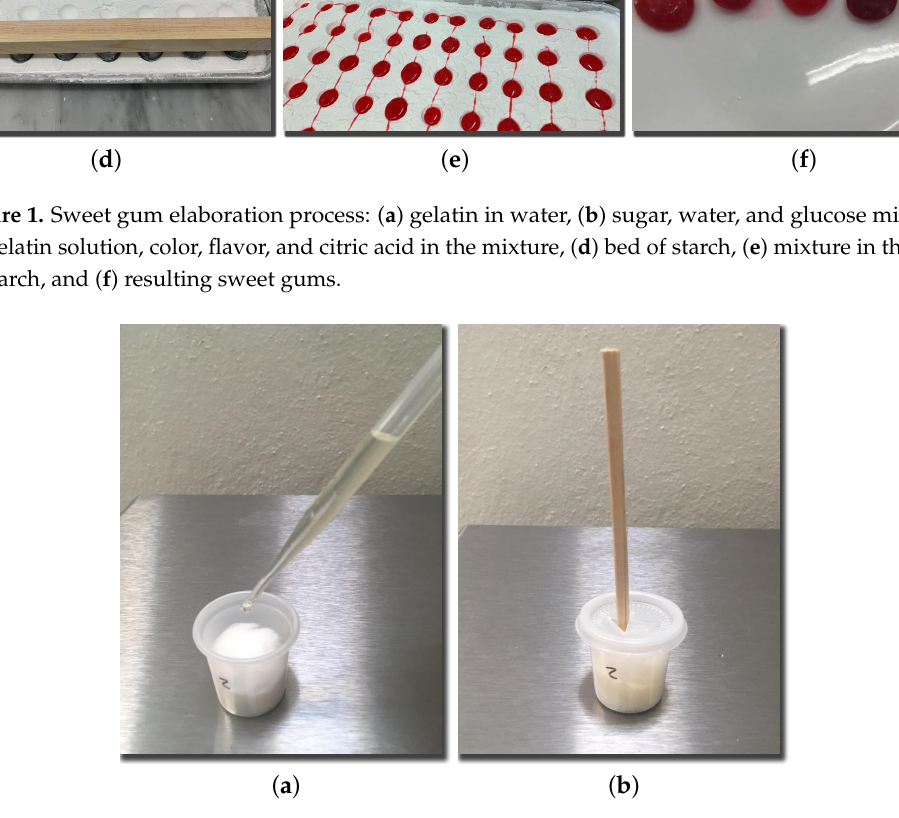
Figure 2. Odor sample: ( a ) Soaking cotton with solution. ( b ) Wooden stick in